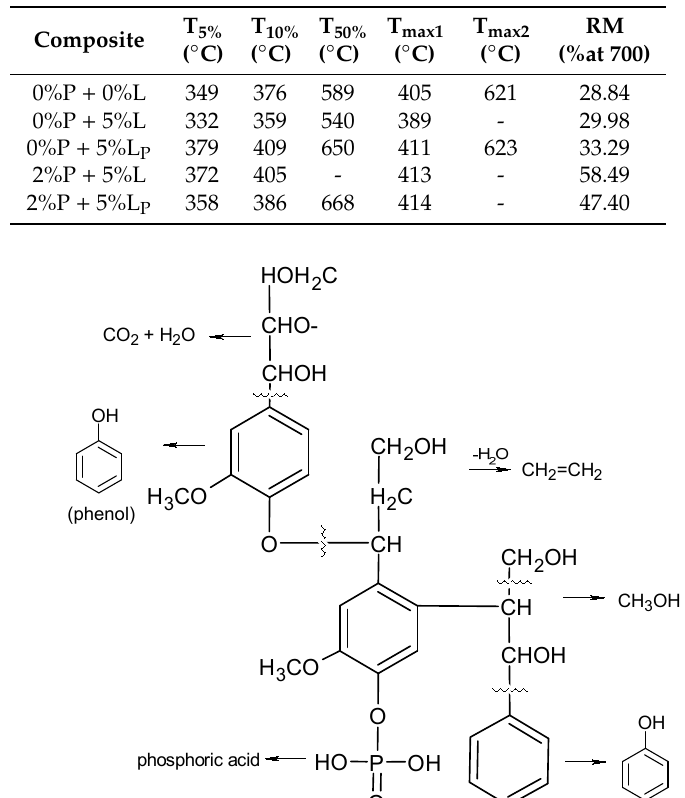
Table 7. TG / DTG data after the flame tests.